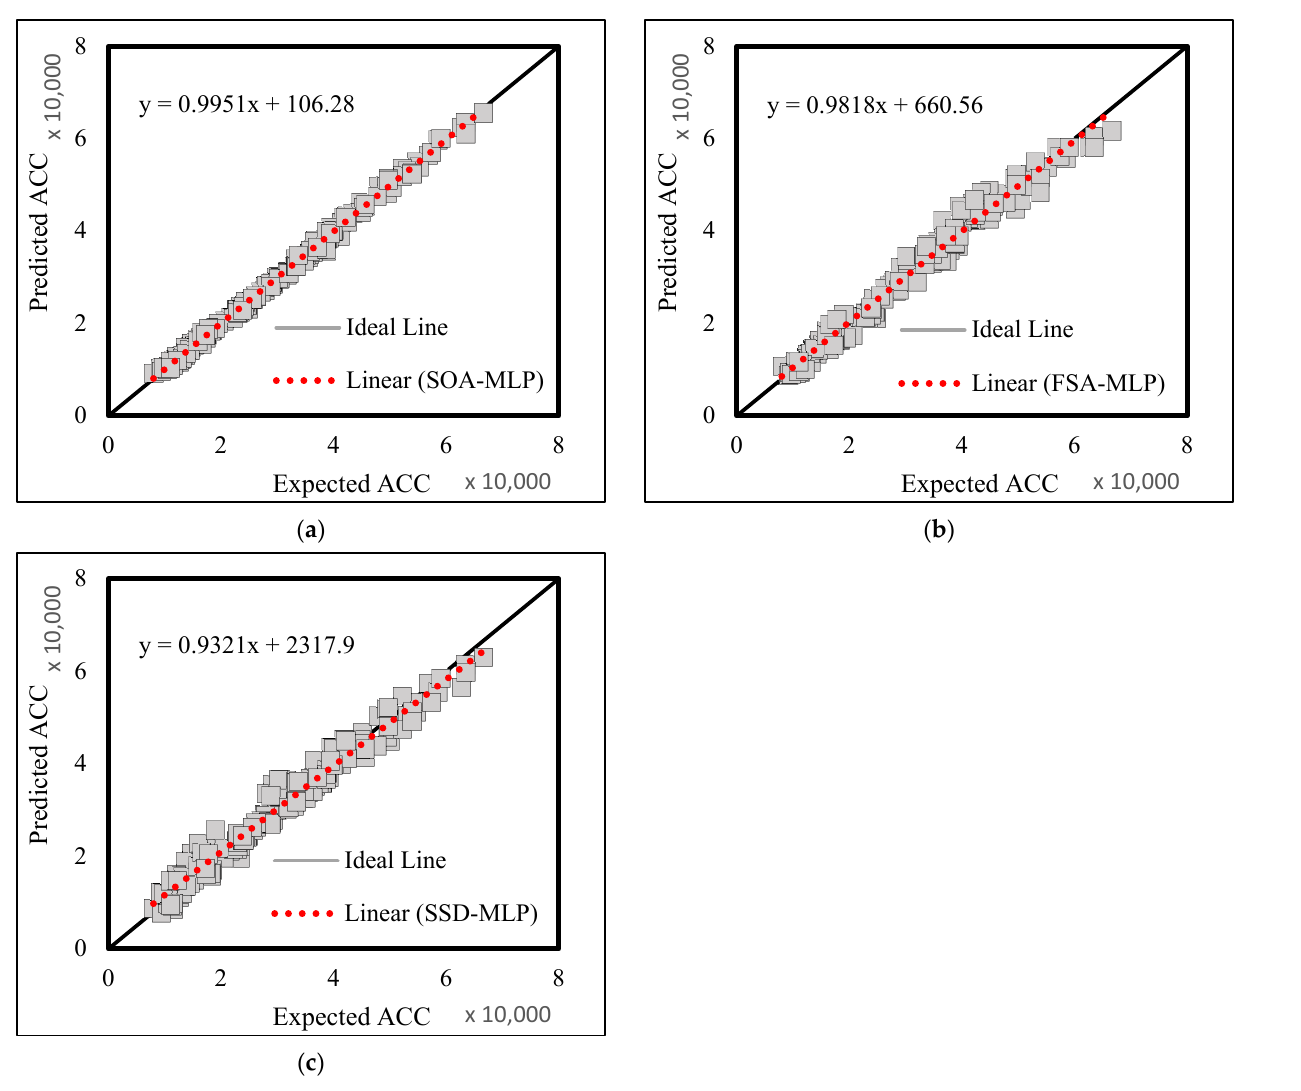
Figure 4. The scatter charts of the testing results for ( a ) SOA-ANN, ( b ) FSA-ANN, and ( c ) SSD-ANN.